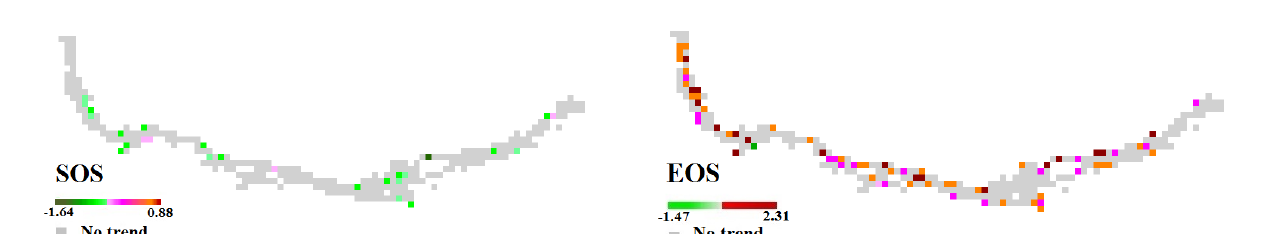
Figure 3: Significant trends at 90% confidence level using Mann- Kendall trend test in start of season date (day/year)